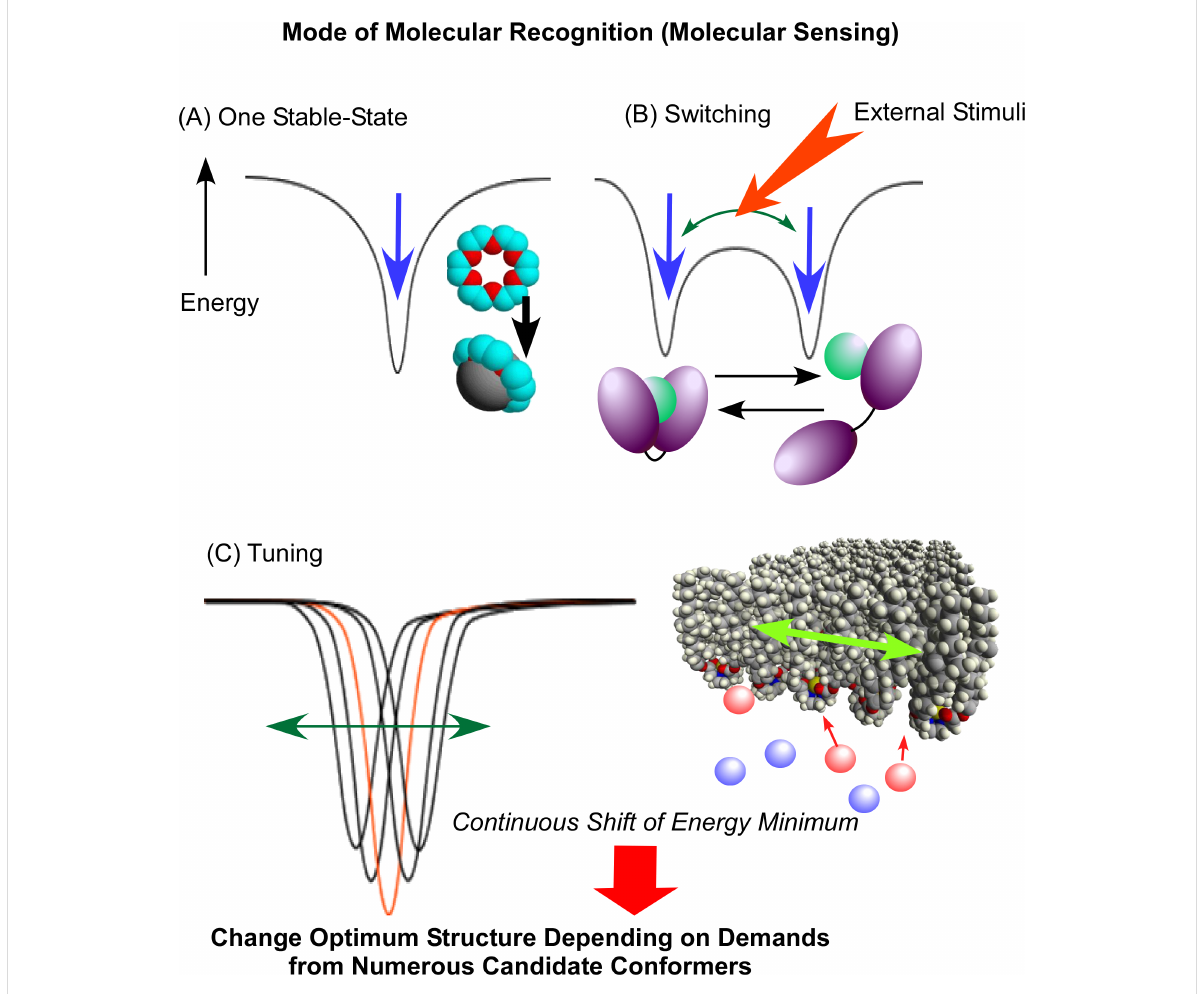
Figure 9: Mode of molecular recognition and sensing: (A) one most stable state between guest and host; (B) switching molecular binding by external stimuli; (c) tuning of receptor structures through continuously shifting molecular conformations for required demands. Adapted with permission